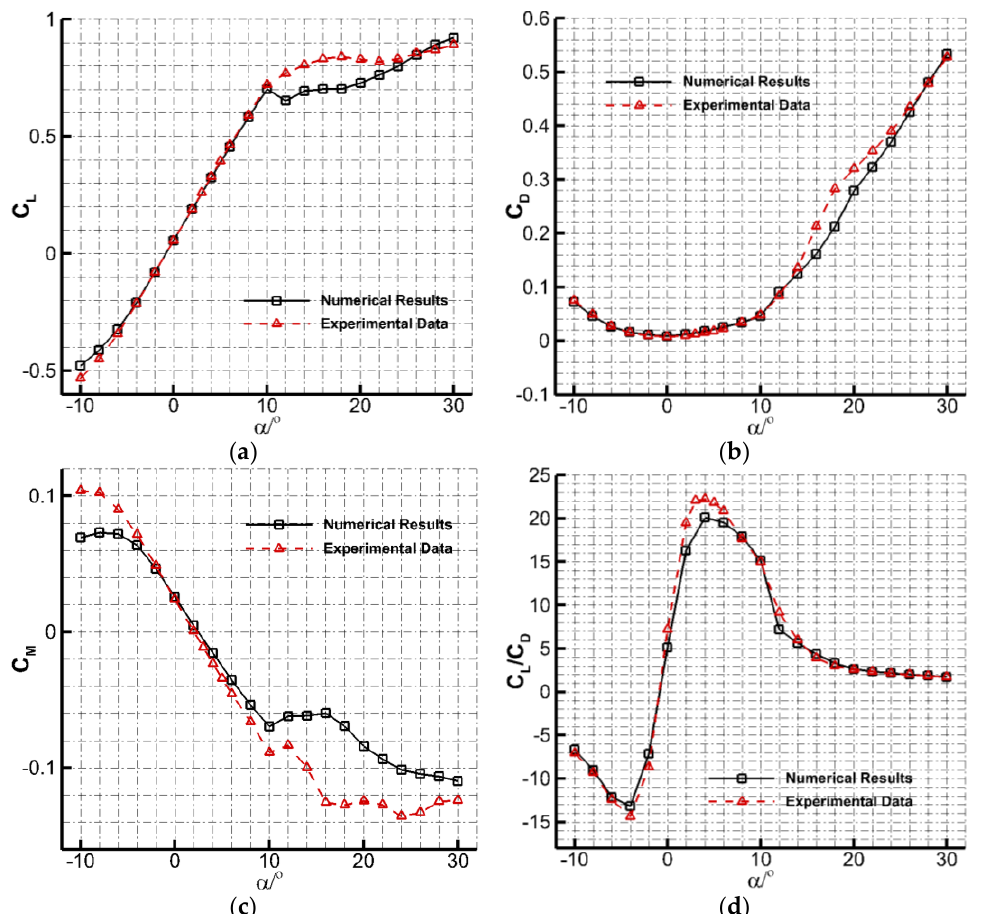
Figure 15 . Comparison of aerodynamic performance between the numerical results and the experimental data. ( a ) Lift performance. (b) Drag performance. (c) Pitching performance. (d) Lift-to-drag performance.